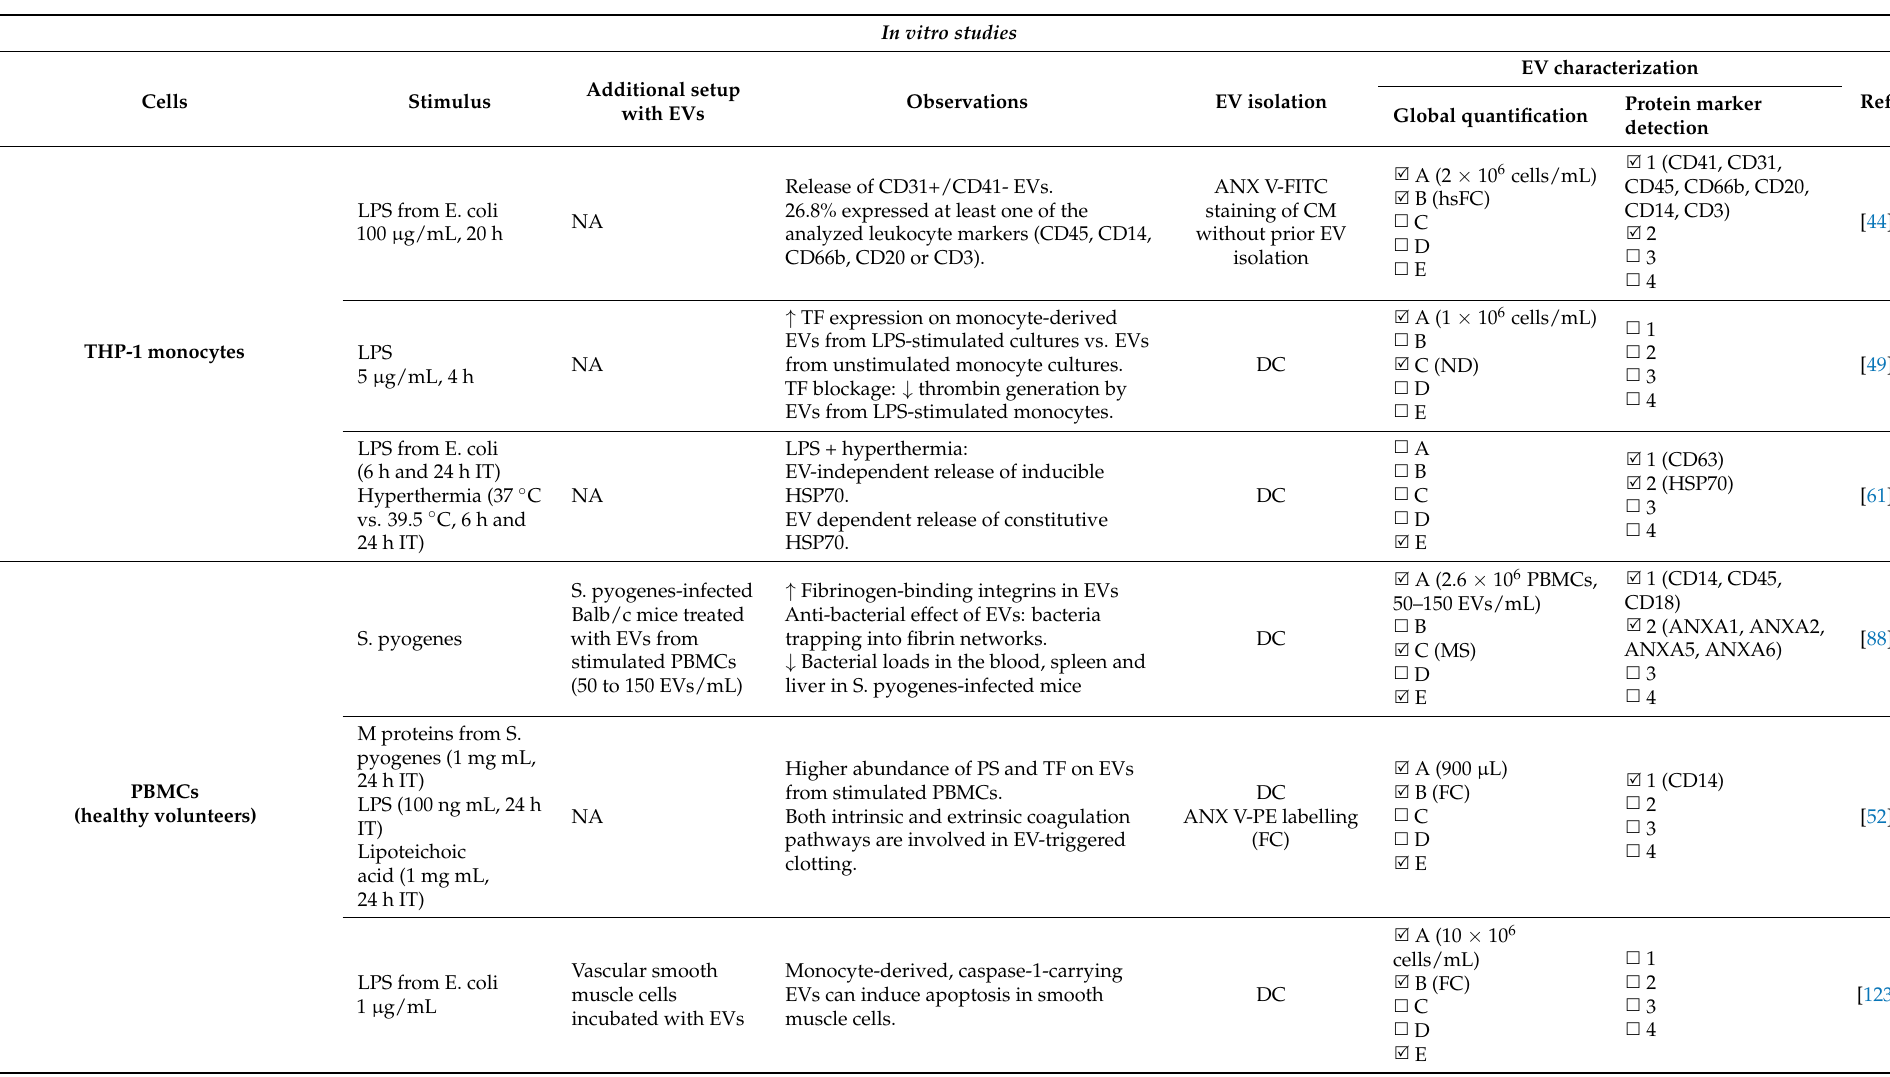
Table 3. Cont. EVs and platelet count at D1 could predict DIC ab- sence.